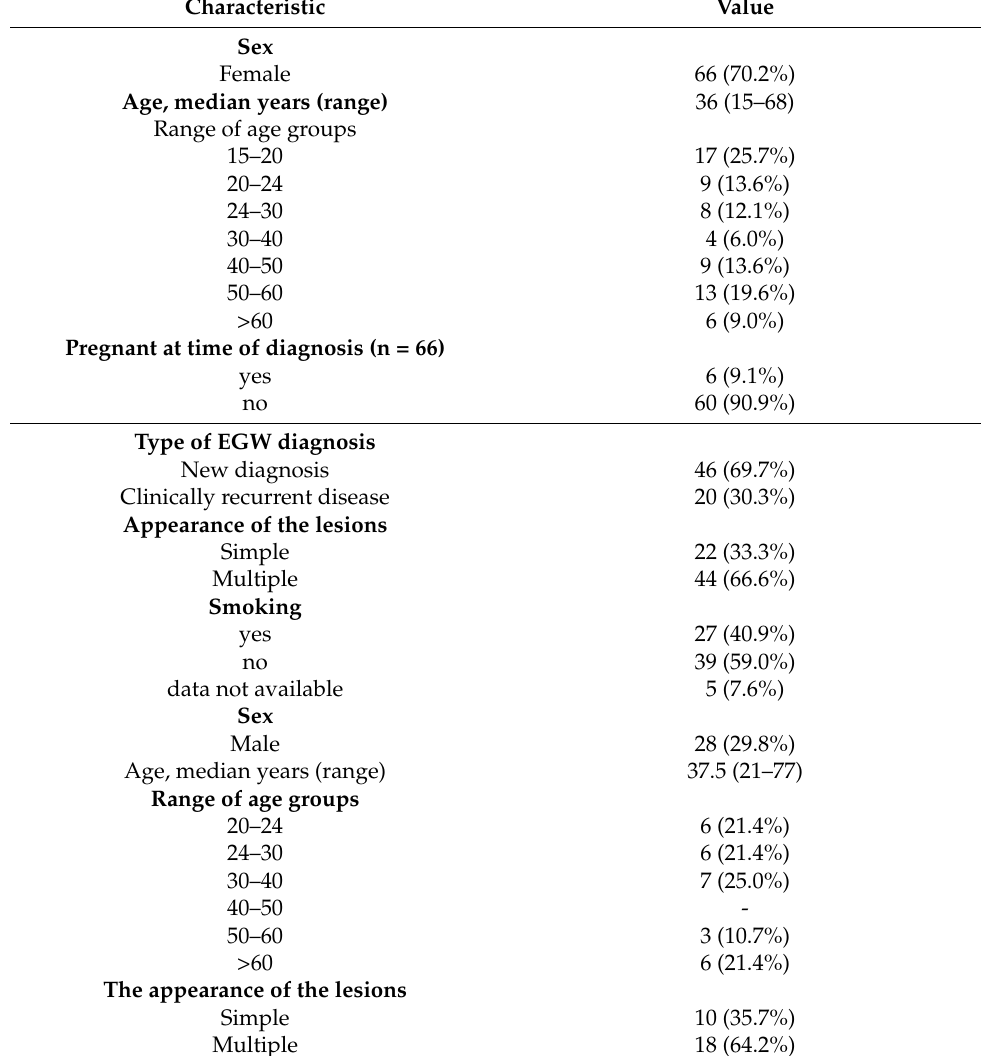
Table 1. Characteristics of ninety-four Hungarian patients diagnosed with external anogenital warts